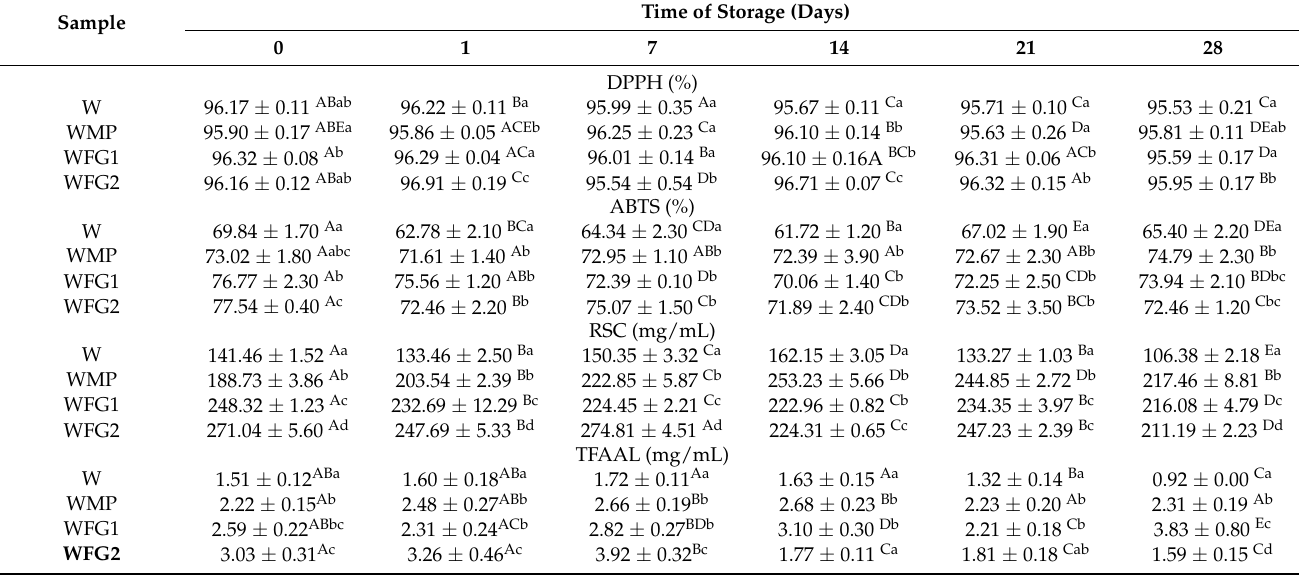
Table 6. Free radicals scavenging activity, reducing sugars content (RSC) and total free amino acids level (TFAAL) of the samples during storage